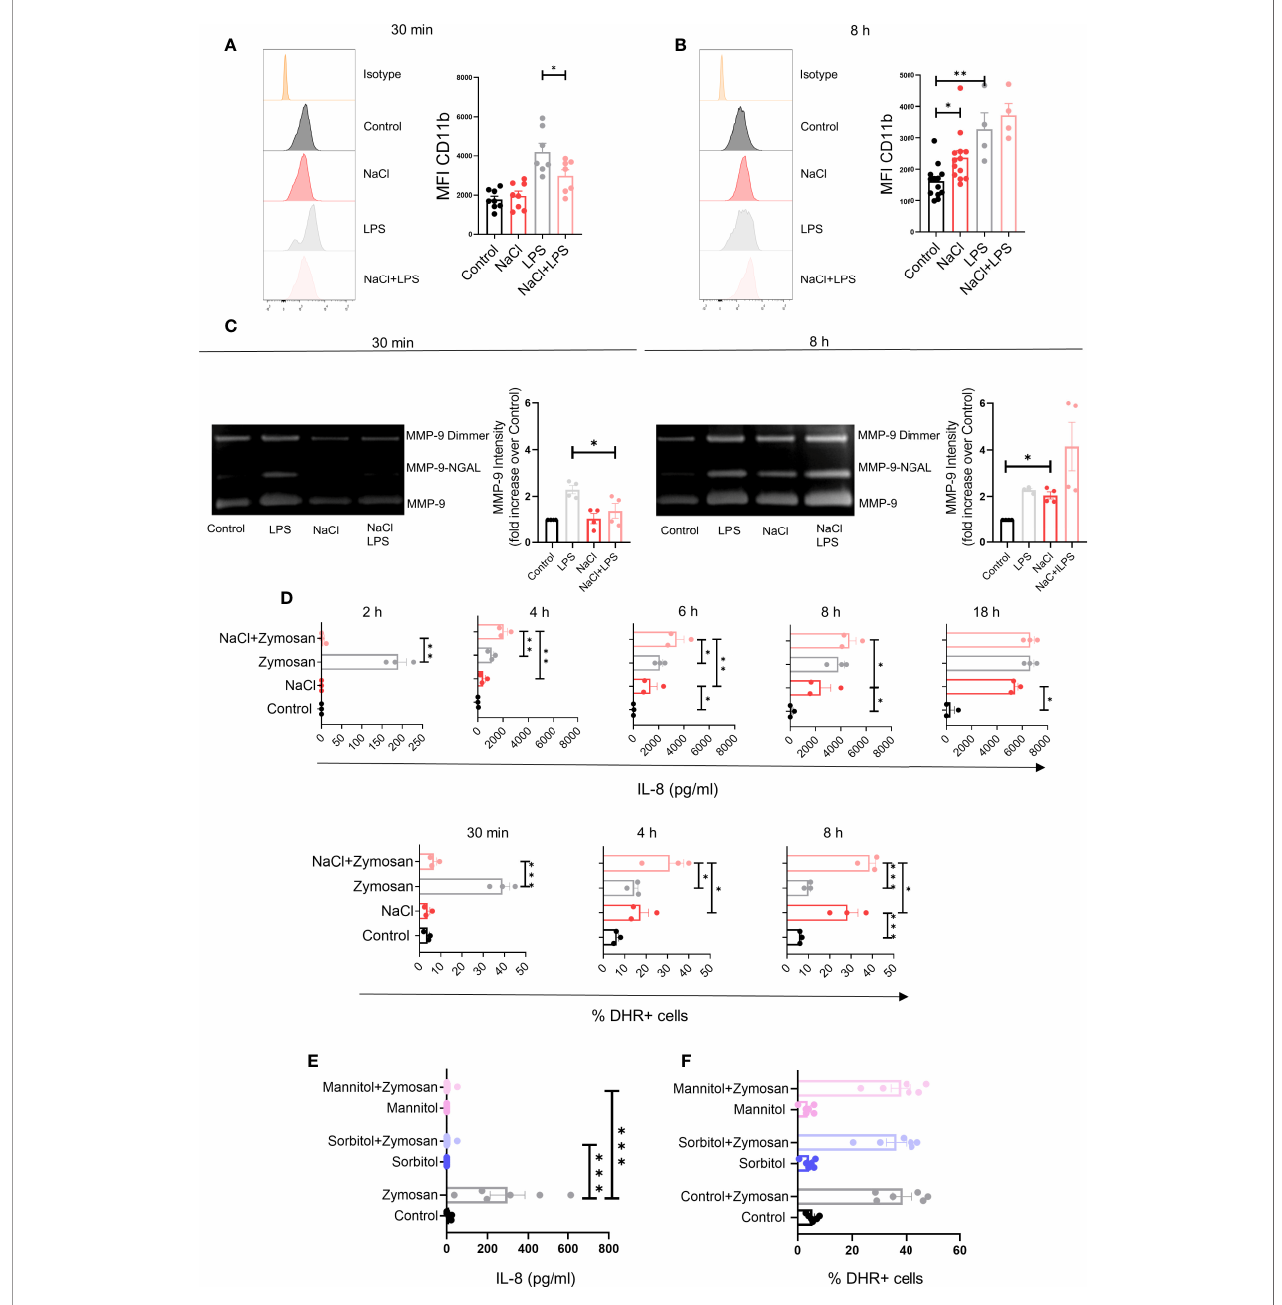
FIGURE 4 | Effect of high salt on neutrophil degranulation induced by LPS and the production of IL-8 and hydrogen peroxide induced by Zymosan. (A , B) Neutrophils (2 x 10 6 /ml) were incubated at 37°C for 30 min (A) or 8 h (B) in culture medium supplemented, or not, with NaCl (50 mM) and/or LPS (100 ug/ml), and the expression of CD11b was then analyzed by fl ow cytometry. Representative experiments and the mean ± SE from 4-13 experiments are shown. (C) Neutrophils (5 x 10 6 /ml) were incubated at 37°C for 30 min or 8 h in culture medium supplemented or not with NaCl (50 mM) and/or LPS (100 ng/ml). Supernatants were then harvested and gelatinase activity was assessed as described under Materials and Methods. A representative experiment and the mean ± SE of 4 experiments are shown. The results are expressed in relative units having assigned the value of 1 to controls (neutrophils cultured in control medium). (D) Neutrophils (2 x 10 6 /ml) were incubated at 37°C for different times in culture medium supplemented, or not with NaCl (50 mM) and/or Zymosan (50 m g/ml). Then, the presence of IL-8 in cell supernatants and the production of hydrogen peroxide were evaluated by ELISA and fl ow cytometry, respectively. Results are expressed as the mean ± SE of 3 experiments. (E , F) Neutrophils were cultured for 30 min in culture medium supplemented, or not, with sorbitol or mannitol (100 mM) and/or Zymosan (50 m g/ml). Then, the presence of IL-8 in cell supernatants (E) and the production of hydrogen peroxide (F) was evaluated by ELISA and fl ow cytometry, respectively. Results are expressed as the mean ± SE from 6 experiments. * P <.05, ** P <.01, and *** P